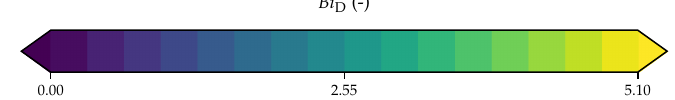
Figure A3. Biot number distributions on cavity side of effusion specimen. Rows show selected configurations; columns show window